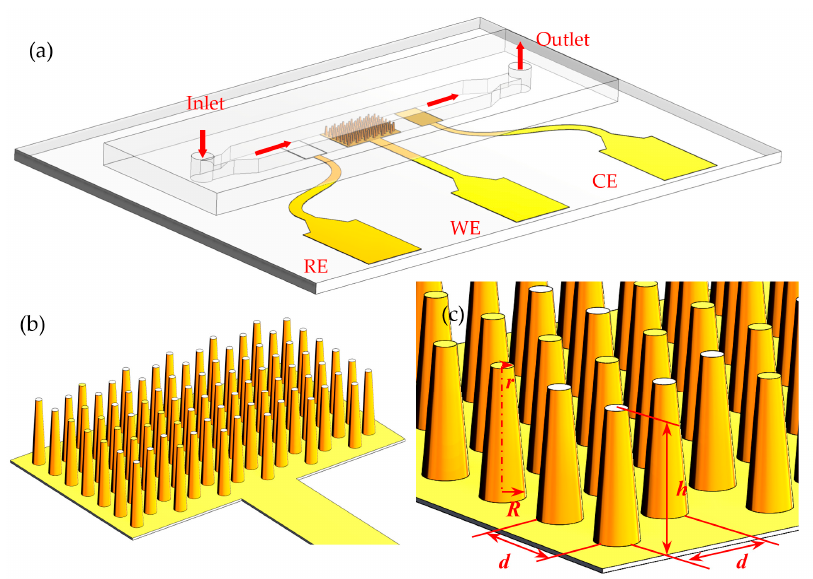
Figure 1. The schematic diagram of ( a ) the µ EDS; ( b ) the µ AE. ( c ) Blow-up view of the µ AE with the definition of the geometrical parameters.